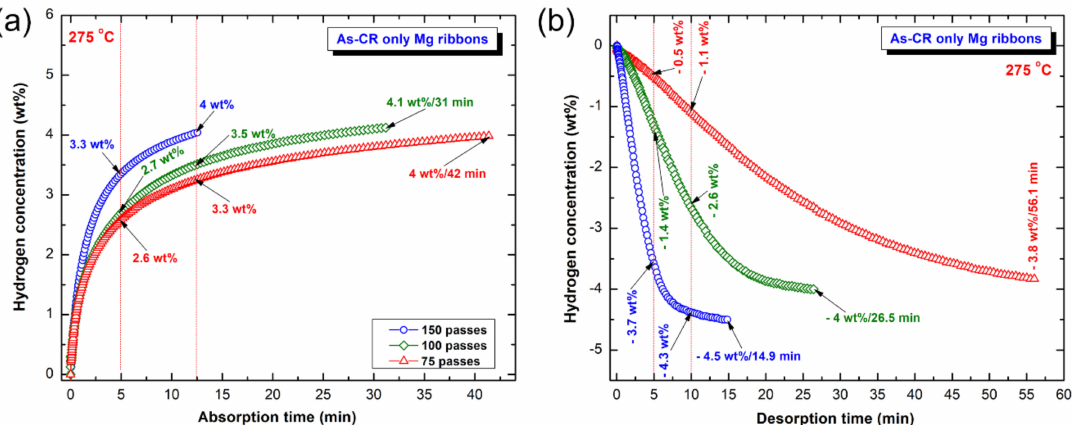
Figure 13. The kinetics of ( a ) hydrogenation, and ( b ) dehydrogenation measured at 275 ◦ C for CR Mg-ribbons obtained after 75, 100 and 150 passes. The hydrogenation and consequent dehydrogenation processes were conducted under 10 bar and 400 mbar of H 2 pressure,